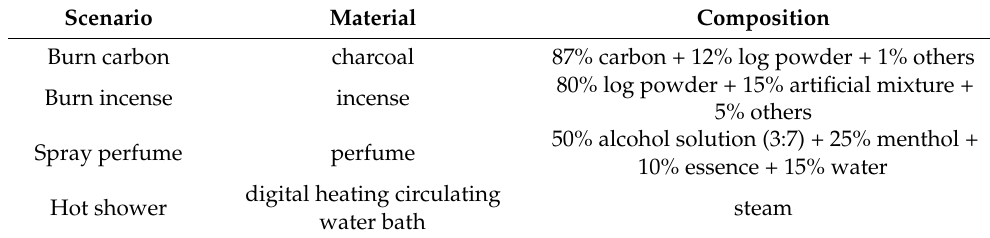
Table 1. Experimental